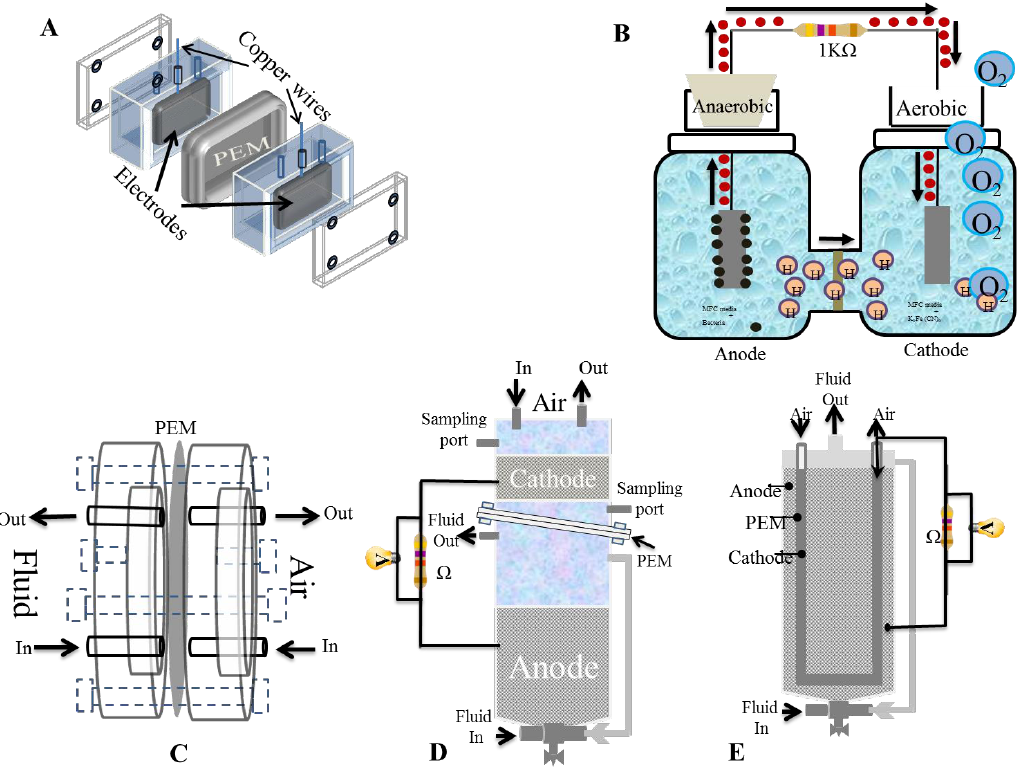
Figure 3. Schematic design of microbial fuel cell configuration.